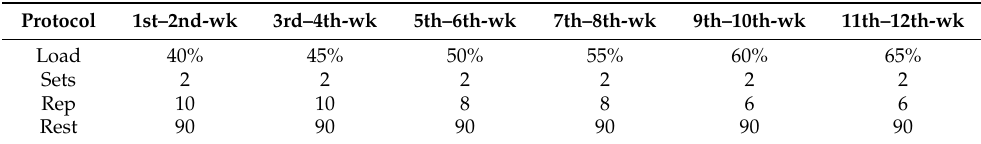
Table 1. Characteristics of the 12-week circuit resistance training programme, comprised of 6 stations, performed by participants in the intervention